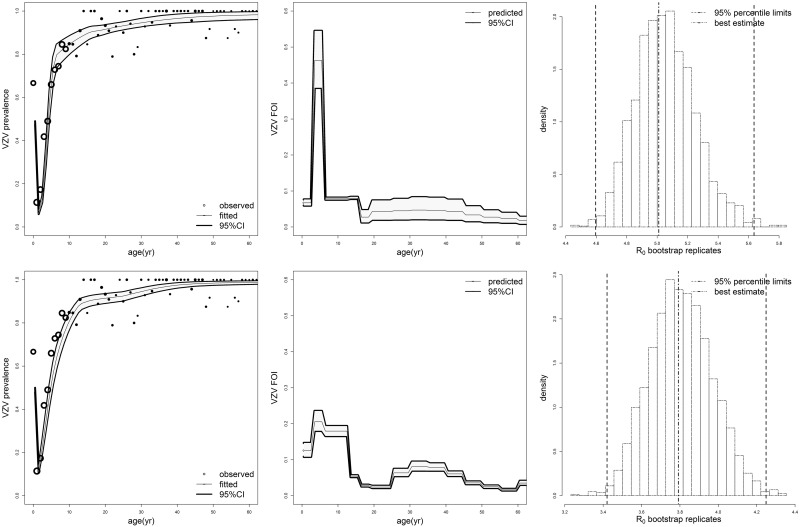
The natural history of VZV in Norway: Fit to seroprevalence data and force of infection.Top row: results from model Q3,16 based on the synthetic matrix; bottom row: results from model Q0 based on the Polymod matrix of close contacts. Left: predicted vs observed varicella age-specific sero-prevalence, with 95% confidence bands. Center: predicted age-specific varicella FOI with 95% confidence bands. Right: best R0 estimate, related distribution of bootstrap estimates and 95% percentile CI. For sake of comparison between models based on synthetic matrices (based on census data, and therefore lacking an uncertainty evaluation) vs models based on Polymod matrices (based on survey data), the bootstrap was done by re-sampling sero-prevalence data only.